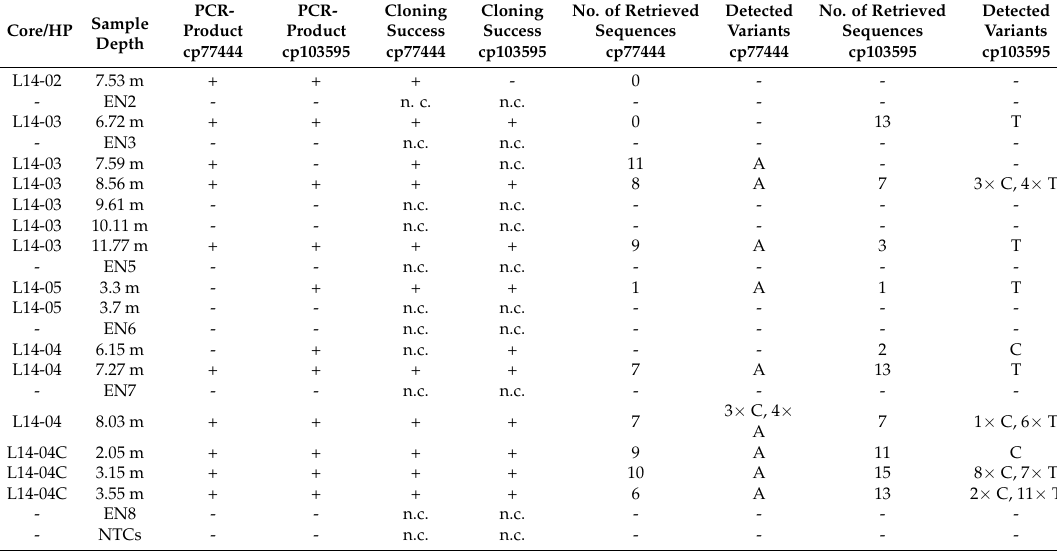
Table 3. List of samples containing Larix sequences in the metabarcoding data, with their extraction negative controls (EN), sorted by the core or hand-pieces (HP) from which they were collected. PCR and cloning success (+: successful, − : not successful) are given, as is the number of retrieved sequences for each sample and the detected SNP variants of the two markers cp77444 and cp103595 including their abundance. If PCRs were not successful, the samples were not cloned